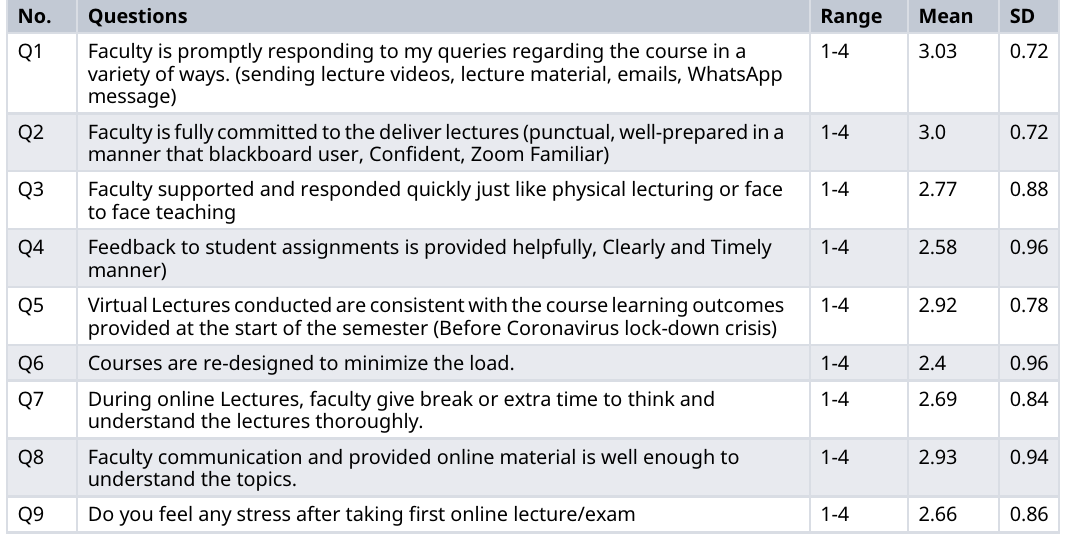
Table 2. Students' satisfaction score with online teaching and learning process.